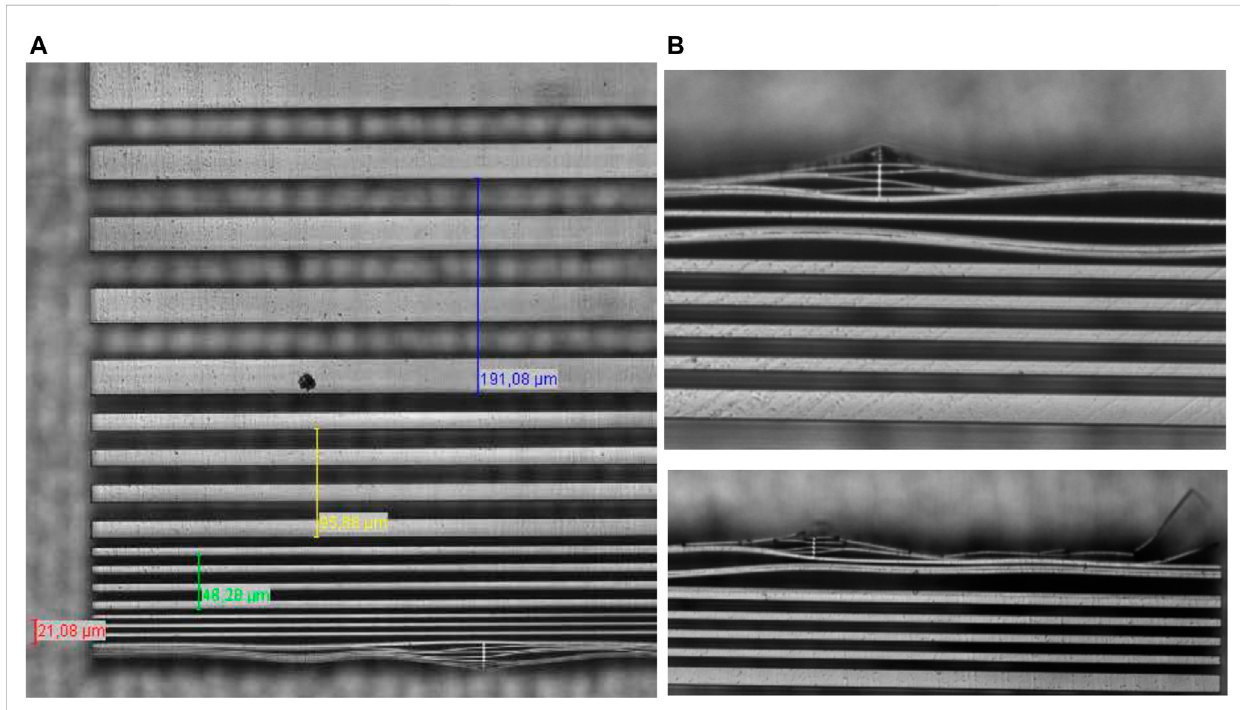
FIGURE 4 (A) Optical microscopic frontal view of the small-scale grids in the XRL phantom. Intact grids with spatial periods of 64 µm (topmost), 32, 16 and 8 µm(lowermost) wereobserved. The smallest correctly aligned platesfeatured aspatial width of 4 µmcorresponding to aspatial frequency of125/mm. Plates with even smaller thickness are not aligned parallel anymore and do lack periodicity. The slit to plate thickness ratio is close to one. (B) top High resolution optical microscopic frontal view of the smallest scale grids in the XRL phantom. The thin plates of 2 µm thickness were tilted and interfolded with neighbouring plates due to lacking mechanical rigidity. The rectangular, stabilizing bars (top side) were only capable to keep the spatial distance between the plates for lateral distances to about 10 – 30 µm. (B) bottom Lamellae below 2 µm thickness (a 8 /2 = 1 µm) at top side right border of the grid showed splitting off and